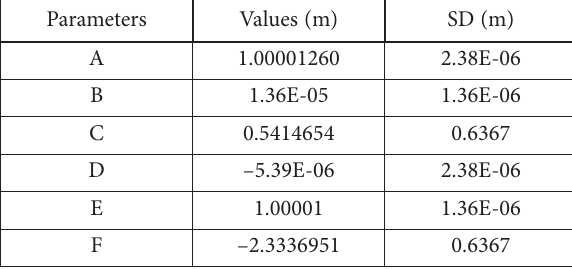
Table 1. 2D affine model transformation parameters from